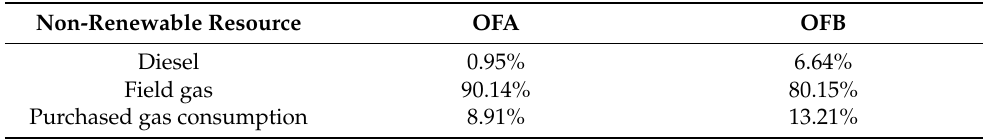
Table 7. Contribution analysis of non-renewable resources expressed as a percentage of the overall carbon footprint produced in an exclusively non-renewable resource